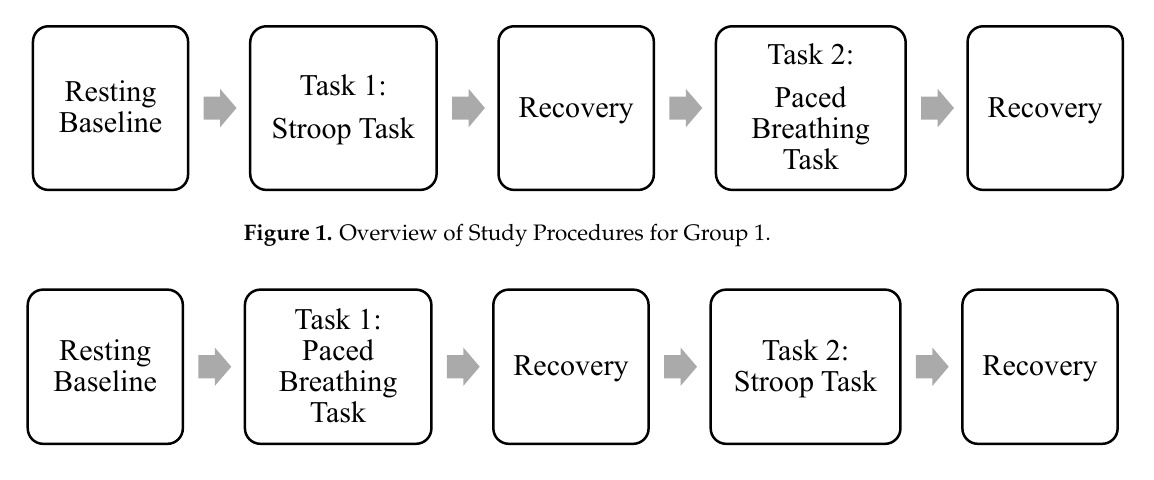
Figure 2. Overview of Study Procedures for Group 2.